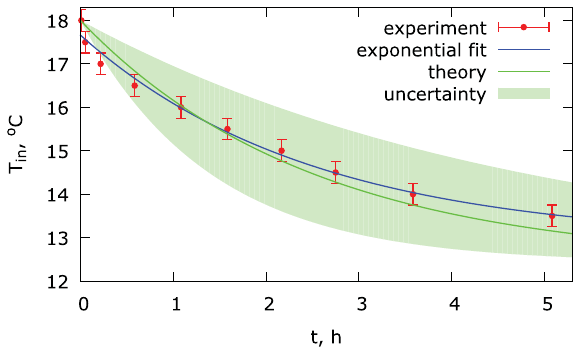
Fig. 7. Results of the experiment (red dots) overplotted with the least-square exponential fi t (blue line) and the theoretical predictions by equation (15) (green line). The area shadowed in light green shows the theoretical uncertainty.